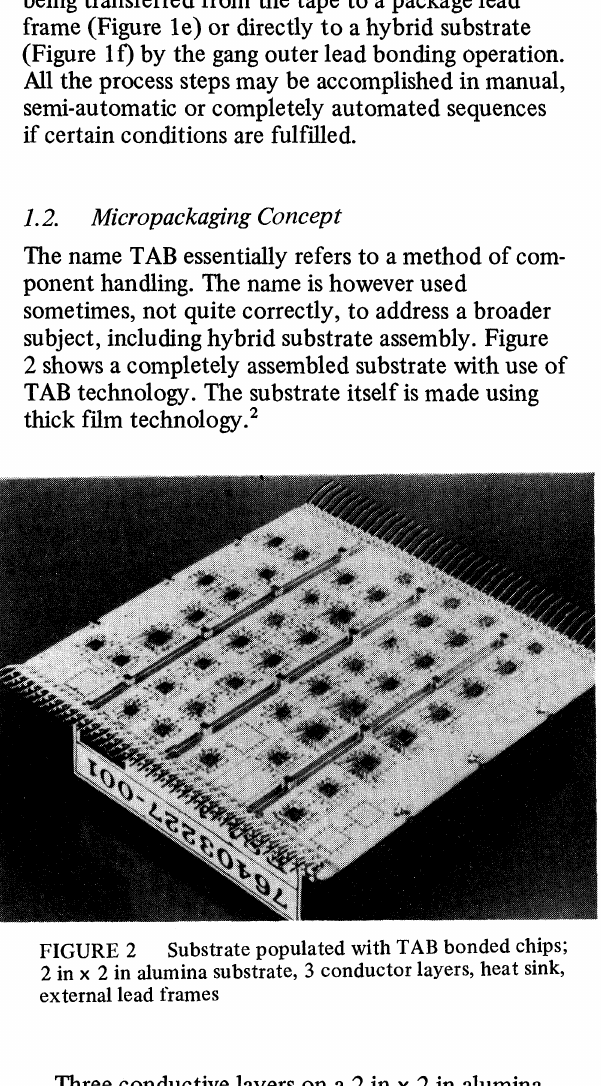
Substrate populated with TAB bonded chips; 2 in x 2 in alumina substrate, 3 conductor layers, heat sink, external lead